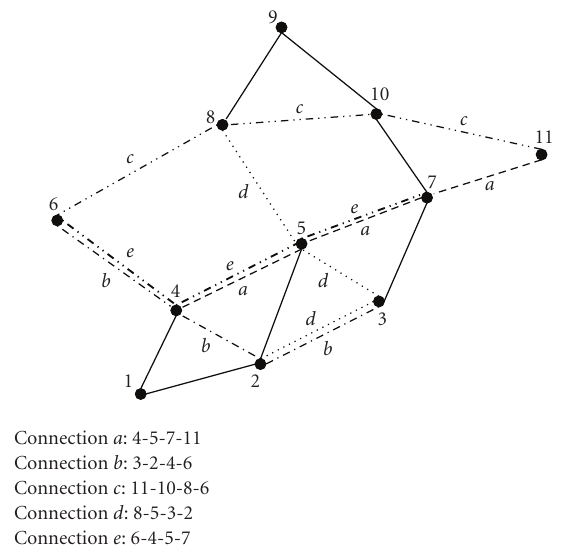
Figure 9: Gain ratio of dynamic case compared to the static one versus K for K (cid:5) = 4 (linear network).